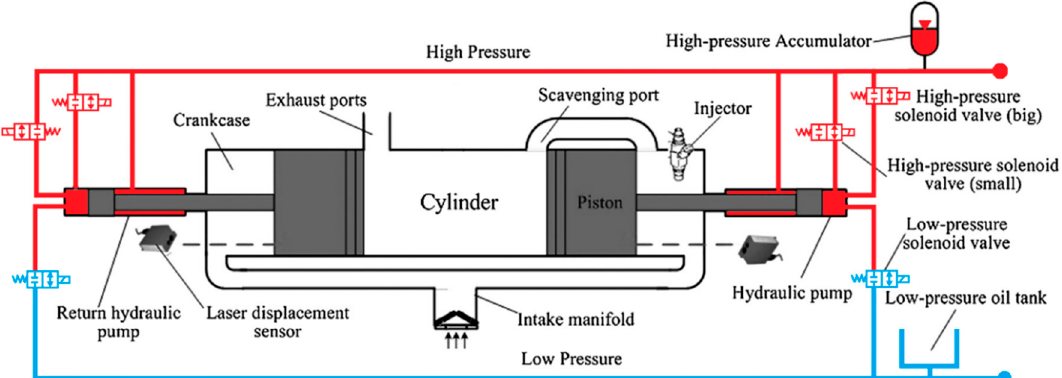
Figure 18. One kind of opposed-piston HFPE [49].